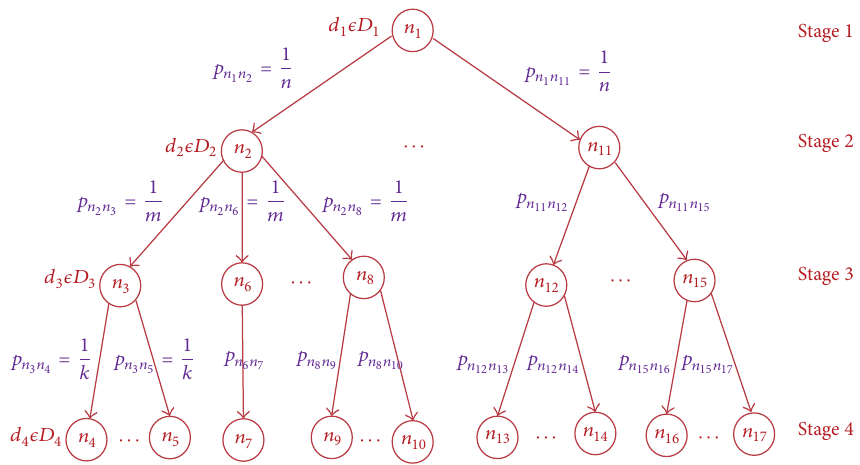
Figure 2: Probabilistic decision at each stage of negotiation